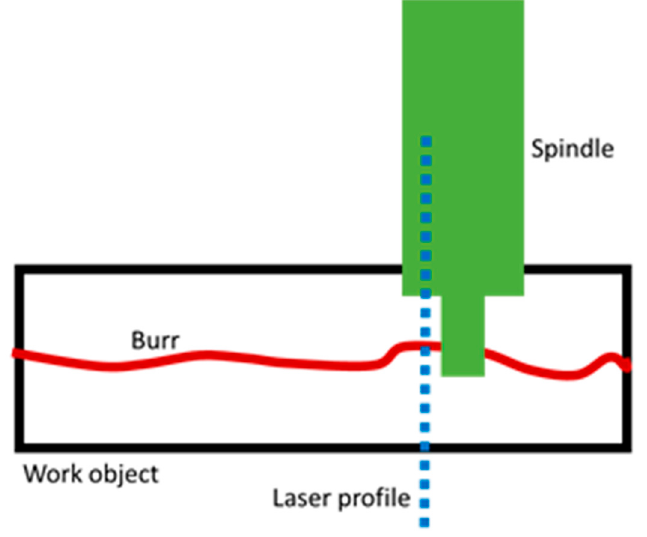
Figure 10. Relative relationship between contour scanning and spindle location.